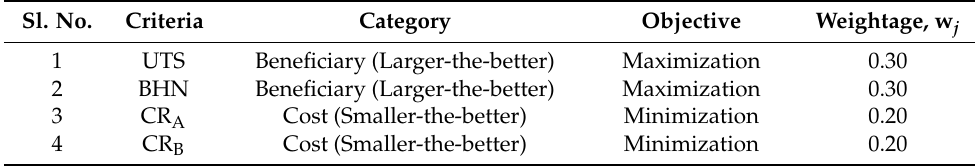
Table 10 indicates the attributes that fall under beneficiary and non-beneficiary cate- gory, with the corresponding weight factors based on their relative importance. Table 10. Attributes and their